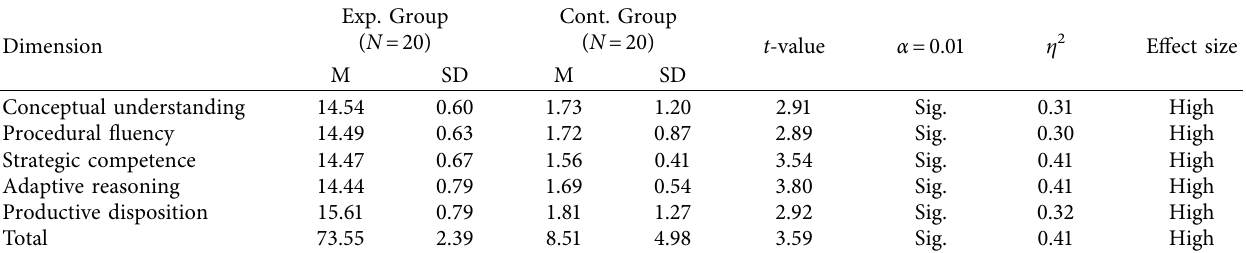
Table 3: Differences between the two groups on the mathematical proficiency post-test.